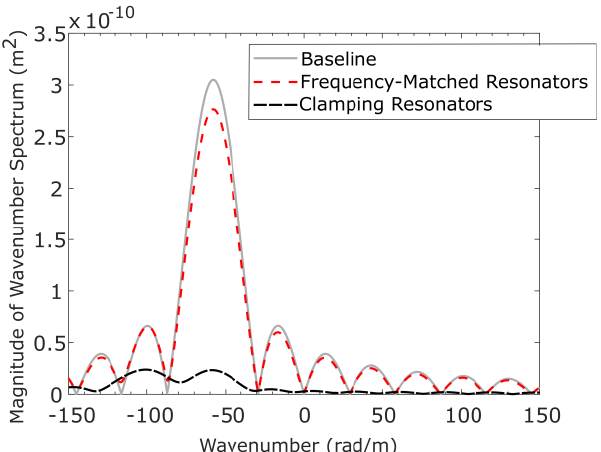
Figure 8. Finite-element-predicted wavenumber spectrum of the guided waves that were allowed to transmit past the resonator array. This spectrum is expected to only contain forward (+ x ) traveling waves.